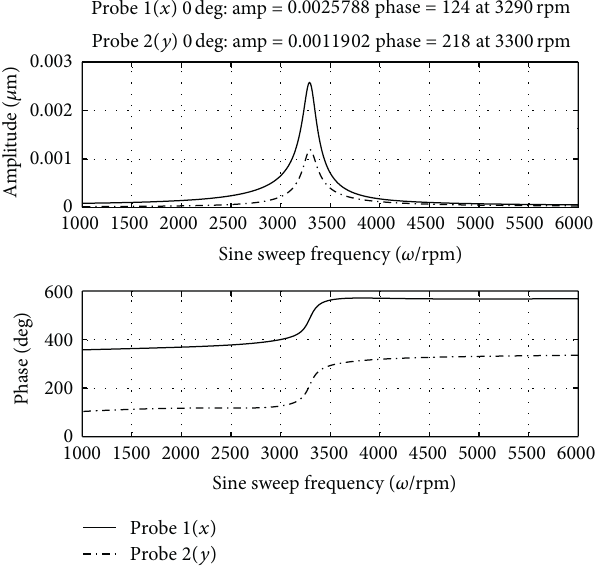
Figure3:Bodeplotoftherotorvibrationresponseundersinesweep